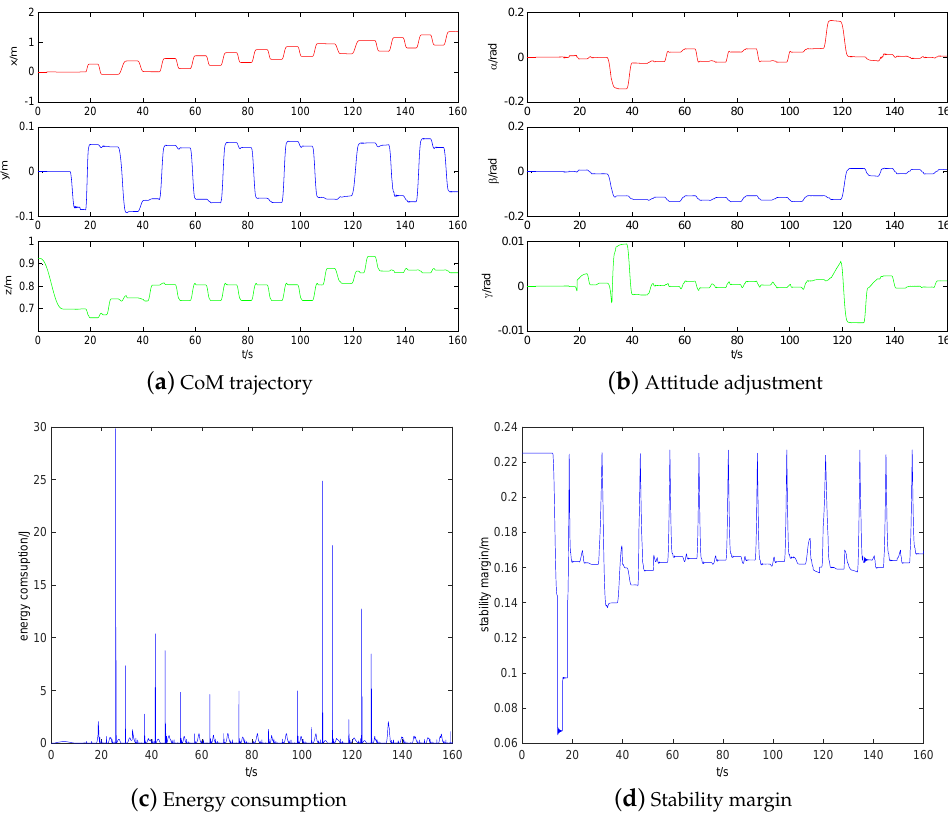
Figure 16. Simulation results of quadruped robot walking on a high platform.